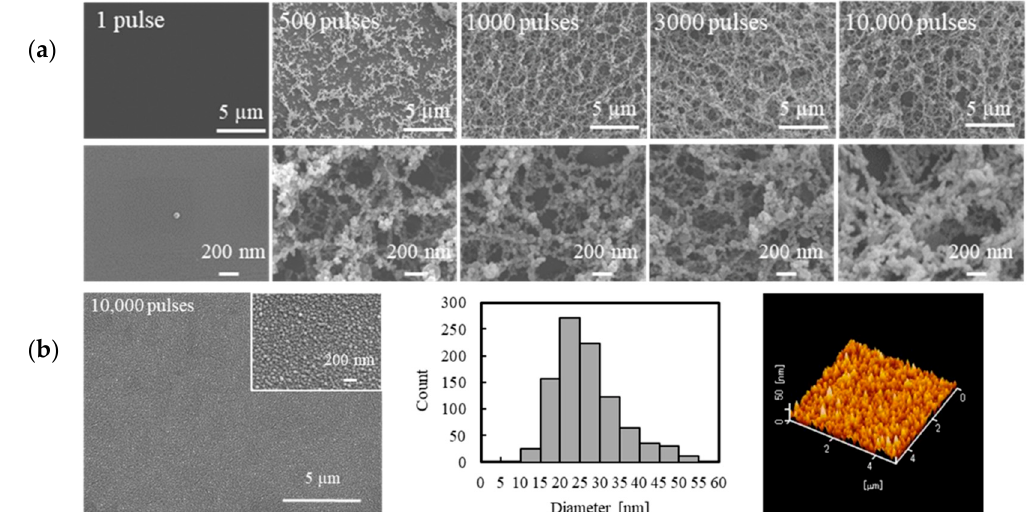
Figure 4. ( a ) SEM images of NPs deposited with different numbers of pulses. Enlarged views are shown at the bottom. The CYTOP-glass distance was 100 µm. ( b ) Low-magnification (left) and enlarged (inset) SEM images, size distribution histogram (middle), and an atomic force microscopy (AFM) image (right) of NPs deposited at a CYTOP-glass distance of 4000 µm. The number of pulses was 10,000.